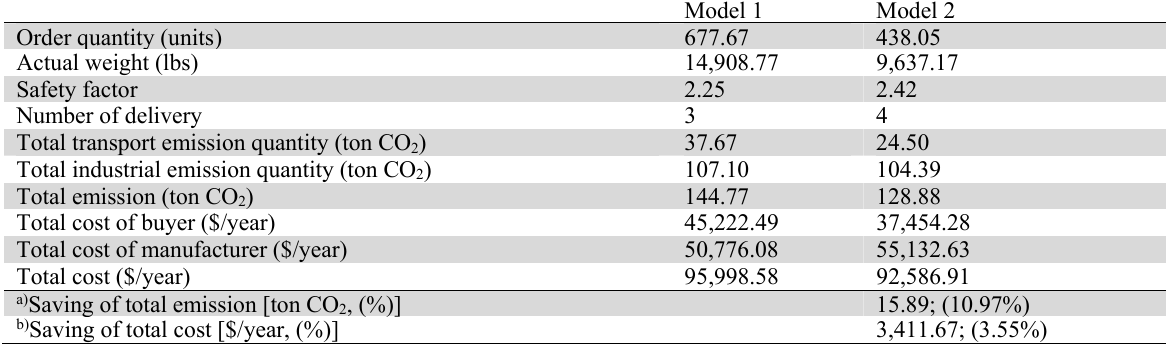
The comparison of model 1 and model